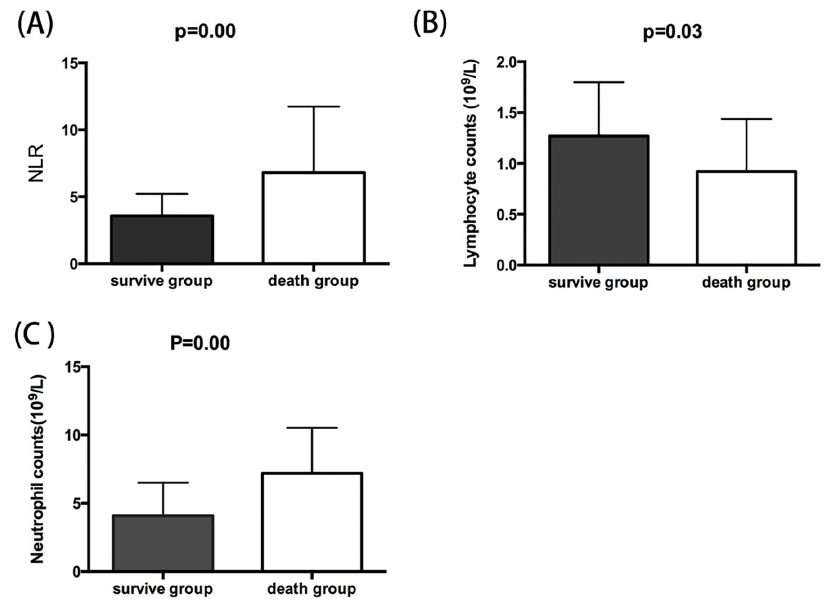
Fig 3. BaselinemedianNLR (A), LC (B), and NC (C) in the SOC group survivors (solid bars) and in patients who died (open bars). Error bars are IQRs.